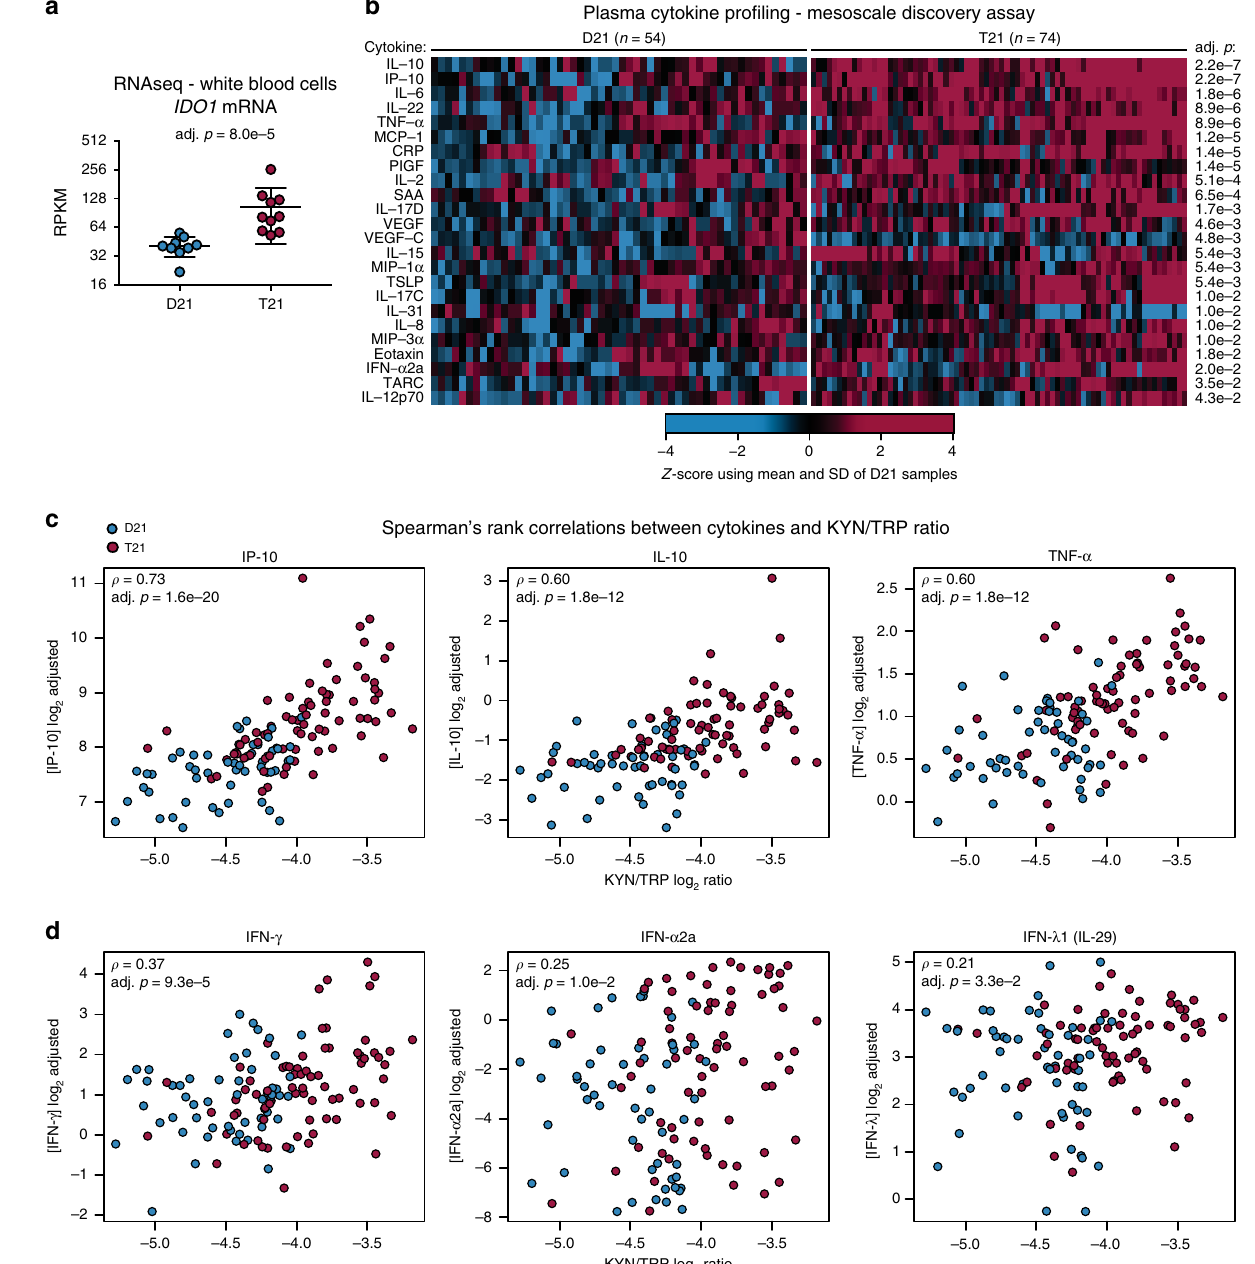
Fig. 2 KP activation correlates with IDO1 and IFN-related cytokines. a Scatter plot showing mRNA expression of IDO1 in white blood cells from controls (D21) and individuals with T21. Statistical signi fi cance was calculated using DESeq2. mRNA expression values are displayed in reads per kilobase per million (RPKM). Bars represent median, 25th, and 75th percentile values. n = 19 independent samples 10 with T21. b Heat map showing signi fi cantly different cytokines identi fi ed in Mesoscale Discovery Assay in Cohort 3. Data from both the D21 and T21 samples were z -scored using the mean and SD from the D21 group. Signi fi cant differences were assessed using the Kolmogorov – Smirnov test and an FDR-adjusted p -value threshold of 0.05. c Scatter plots comparing kynurenine to tryptophan ratios to levels of the three most signi fi cantly correlated cytokines, IP-10, IL-10, and TNF- α . d Scatter plots comparing kynurenine to tryptophan ratios to levels of three signi fi cantly correlated interferons: IFN- γ , IFN- α 2a, and IFN- λ (IL-29). Spearman ’ s rho ( ρ ) and FDR-corrected p -values are indicated for each pair. Panels b – d measured Cohort 3, n = 128 independent samples, 74 with T21 for panel b , n = 124 samples, 72 with T21 for panels c and identi fi ed 31 signi fi cant correlations (Supplementary Data 15). At the top of this list were three cytokines known to be induced by IFN signaling, the proin fl ammatory molecules IP-10 (IFN- γ - induced protein 10, CXCL10) and TNF- α , as well as the anti- in fl ammatory cytokine IL-10 (Fig. 2c and Supplementary Data 15). Furthermore, three IFN ligands were positively